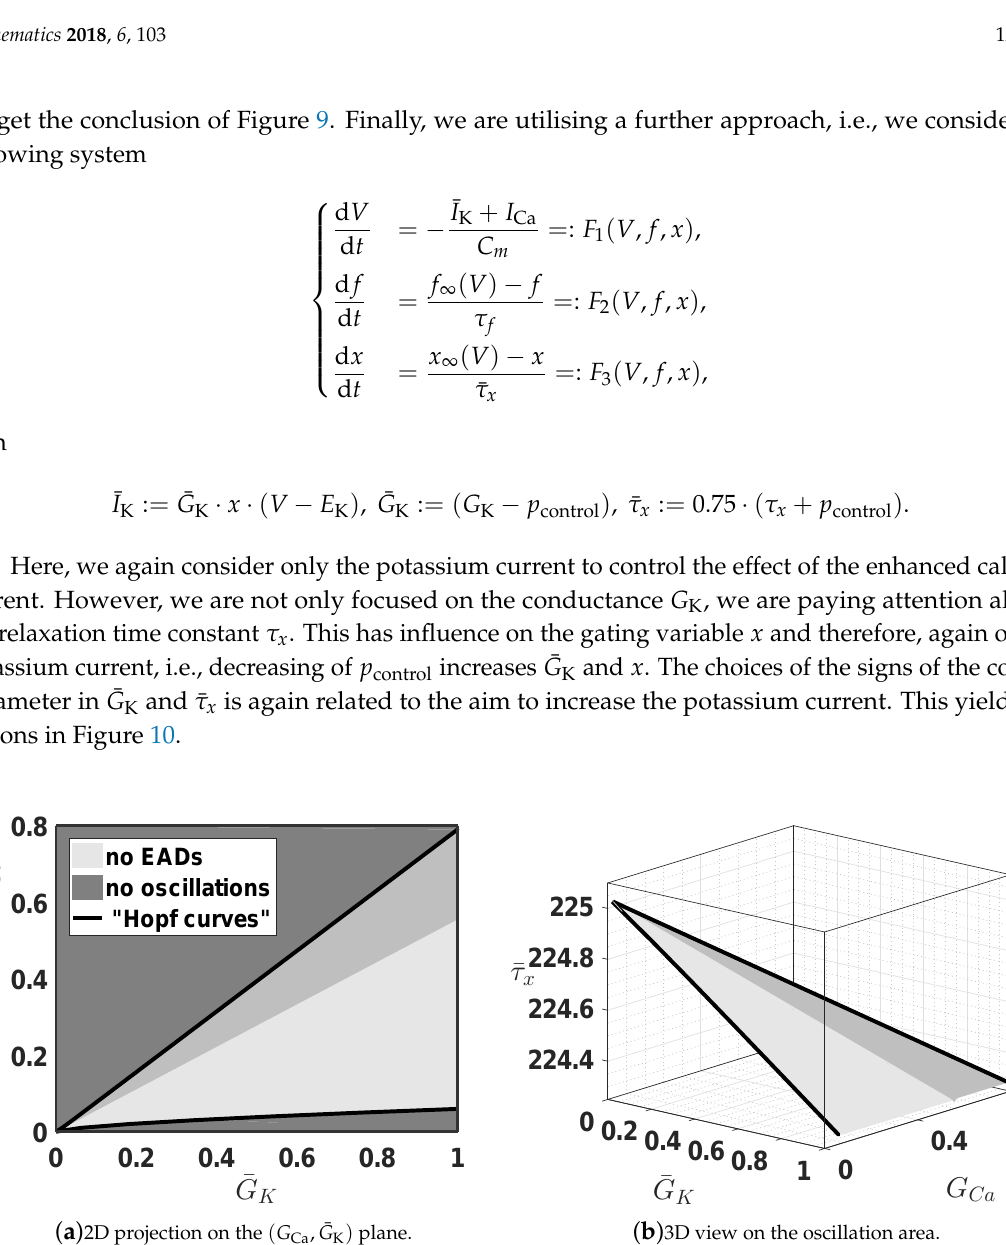
( b ) 3D view on the oscillation area. Figure 10. The black lines represent the two "Hopf-curves" of system (8) including the oscillatory